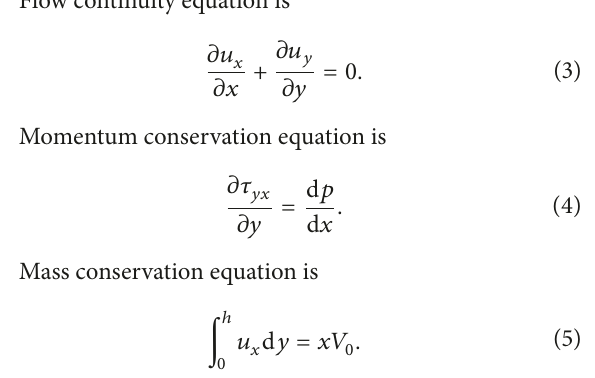
Figure 3: Operation mode of ferrofluid in the working clearance.